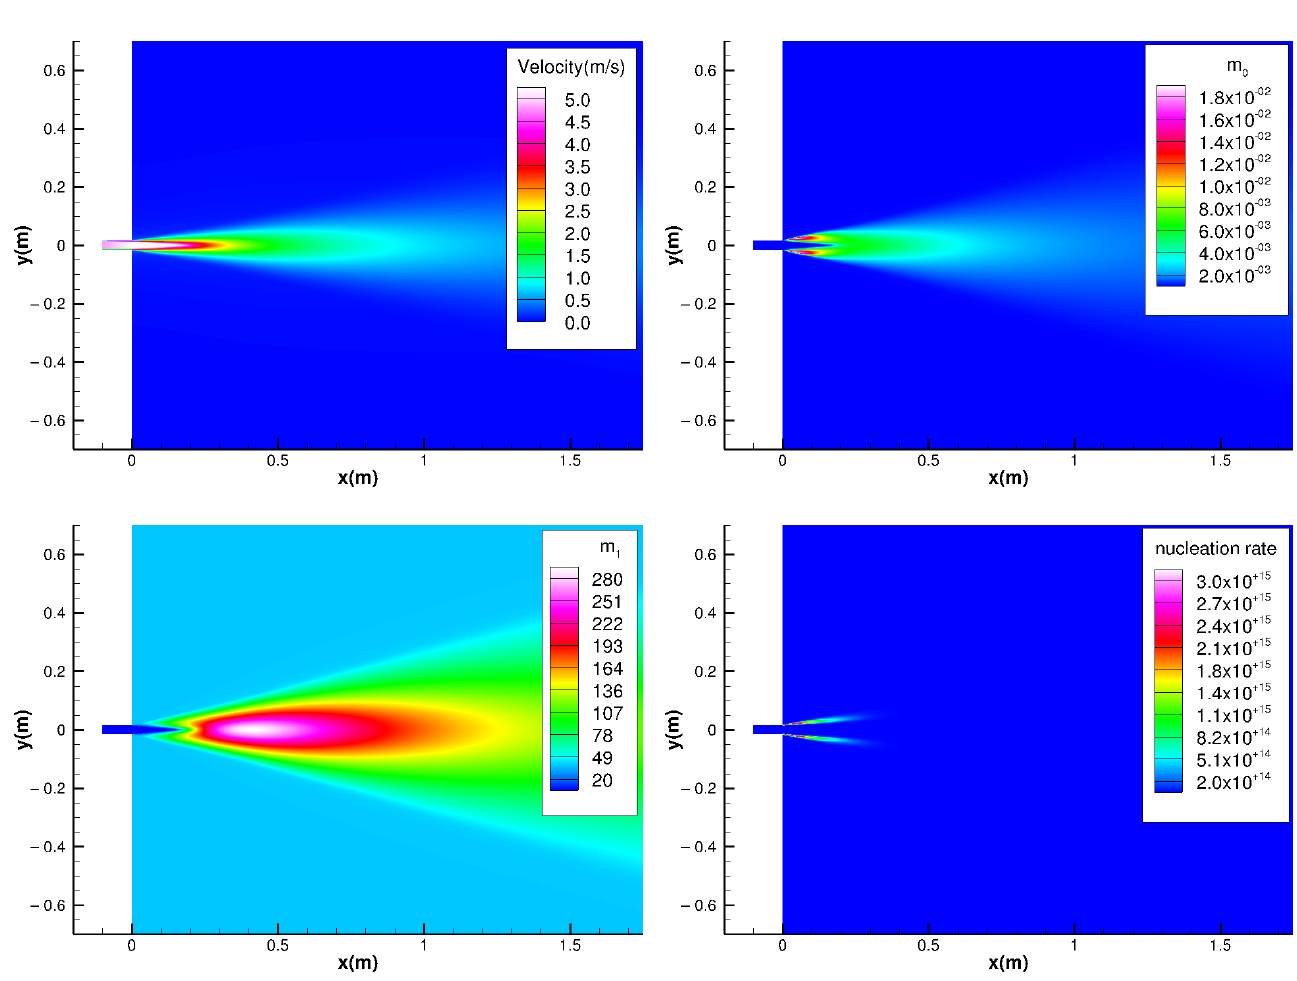
Figure 2. No polluted flow field data in